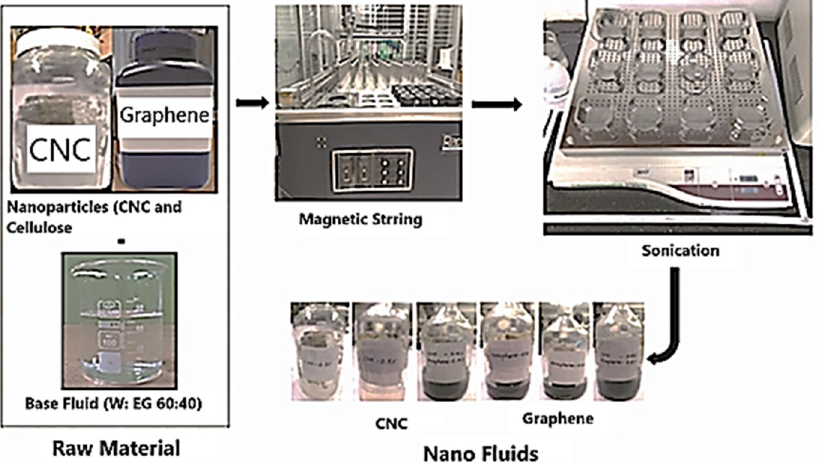
Figure 5. E xperimental presentation of CNC and graphene hybrid nanofluids preparation. Figure 5. Experimental presentation of CNC and graphene hybrid nanofluids preparation.